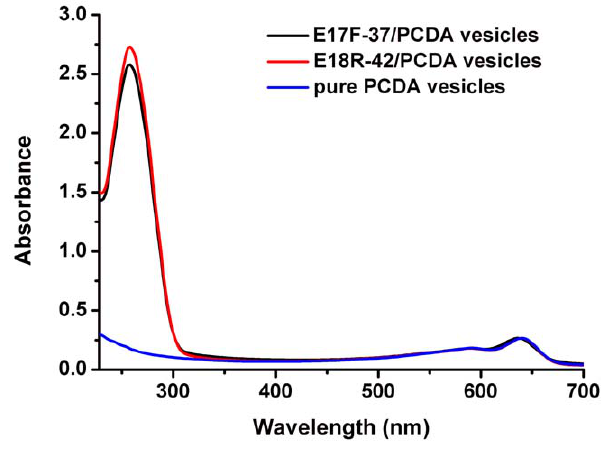
Figure 2. UV-vis absorbance spectra of pure PCDA vesicles before (blue curve) and after binding aptamers (red and black curve).